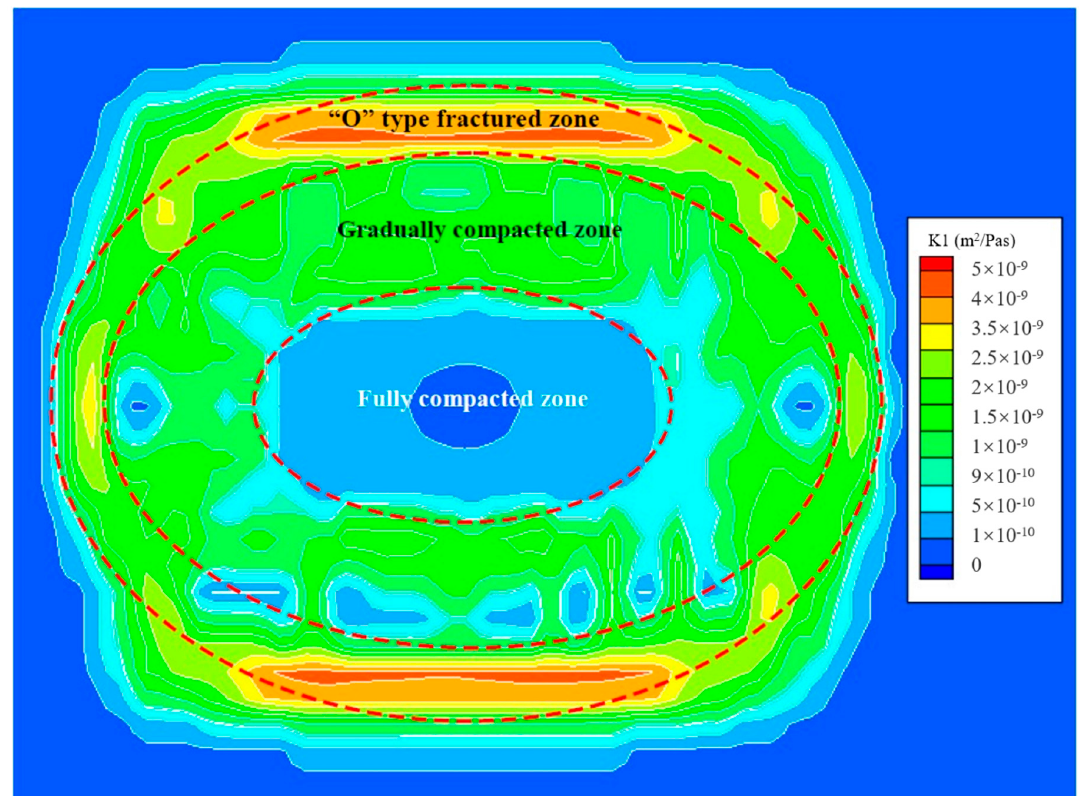
Figure 7. The contour plotting of permeability distribution in protected coal seam.